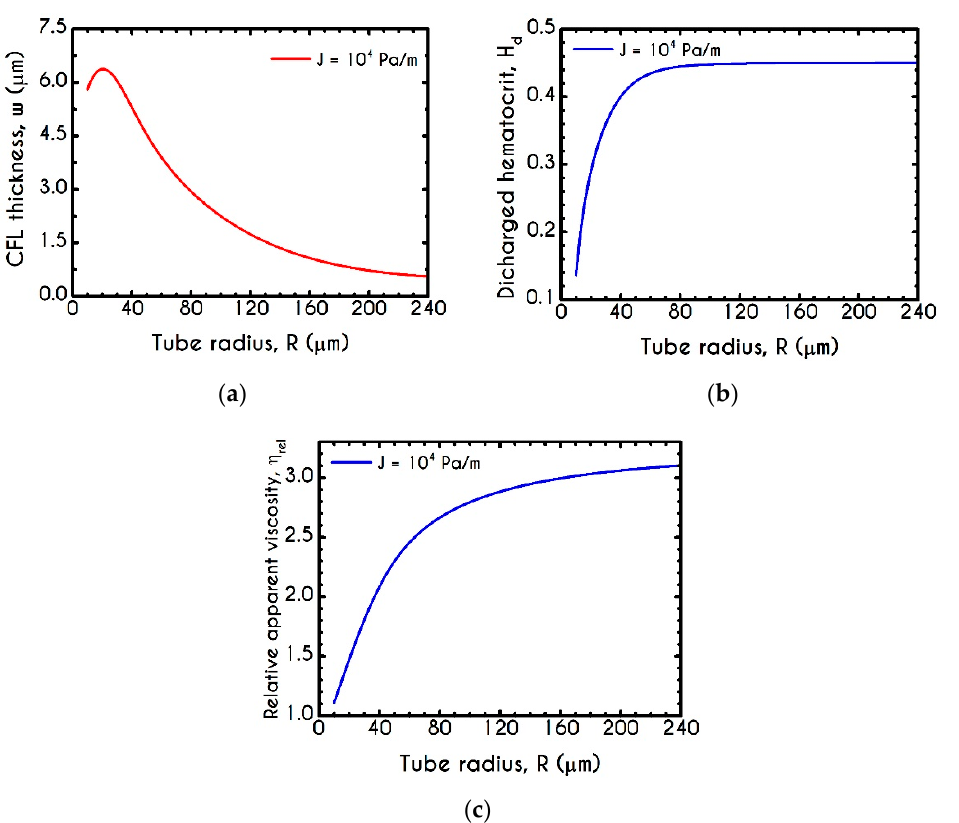
Figure 14. ( a ) Cell-free layer thickness w , ( b ) discharged hematocrit H (cid:2914) , and ( c ) the relative Figure 13. ( a ) Cell-free layer thickness w, ( b ) discharged hematocrit H d , and ( c ) the relative apparent apparent viscosity η (cid:2928)(cid:2915)(cid:2922) , as a function of tube radius R for J = 10 (cid:2872) Pa/m and H (cid:2913) = 0.45 . viscosity η rel , as a function of tube radius R for J = 10 4 Pa/m and H c = 0.45.